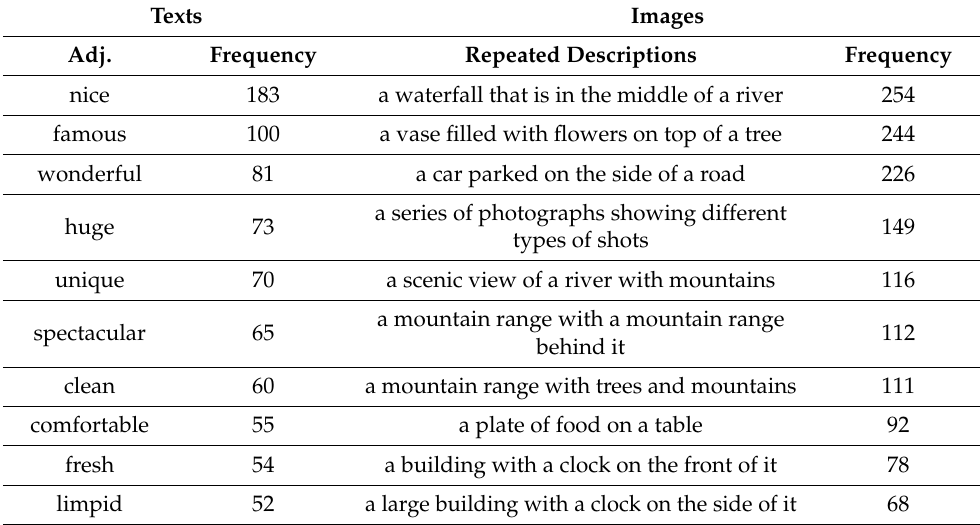
Table 1. High-frequency adjectives and photograph descriptions in Tiantai (top